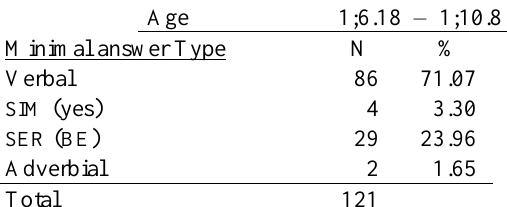
Table III. Frequency of minimal answers in Tomás’